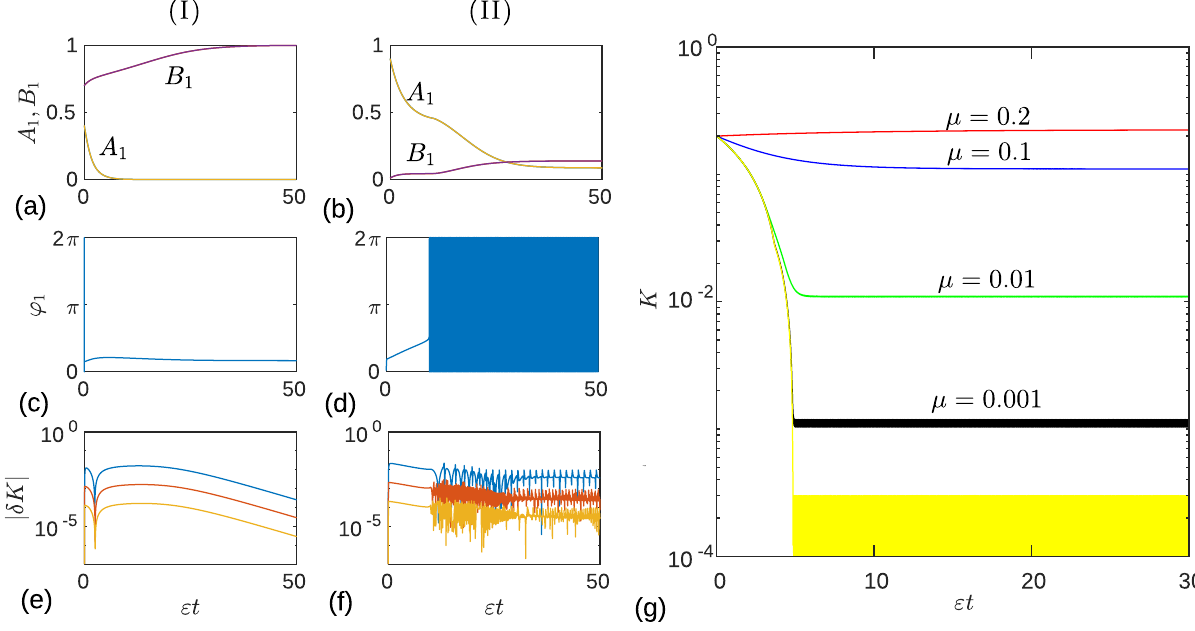
Figure 3. Dynamics of state variables of two oscillators under PDDP. Columns (I) and (II) represent two different initial conditions, which lead to different asymptotic modes: synchronized state (I) and unsynchronized state (II). ( a , b ) Dynamics of slow variables A 1 ( t ) and B 1 ( t ) . ( c , d ) Dynamics of the phase 0.001 . ( e , f ) Dynamics of difference ϕ 1 ( t ) . The values of the parameters are the same as in Fig. 1 except for ε = δ K ( t ) the absolute value of the deviation of the solution of the reduced system of Eqs. (11) and (15) from the | | solution of the original system of Eqs. (3) and (7) for different values of the parameter ε : 0.1 (blue), 0.01 (red) A 1 ( t ) B 1 ( t ) obtained from Eqs. (3) and (7) for the and 0.001 (orange). ( g ) Dynamics of the variable K ( t ) = + sigmoid boundary function with different values of the parameter µ : 0.2 (red), 0.1 (blue), 0.01 (green), and 0.001 (black). The curves move downward as the parameter µ decreases. The lower yellow curve corresponds to the 0.001 Heaviside step boundary function. The initial conditions are the same as in the second column and ε =